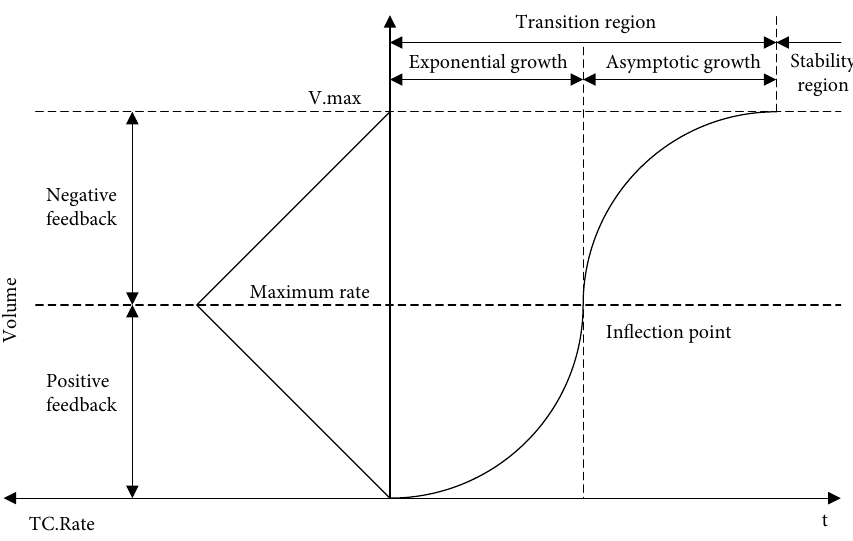
Figure 2: Curve chart of passenger flow growth and change of modern